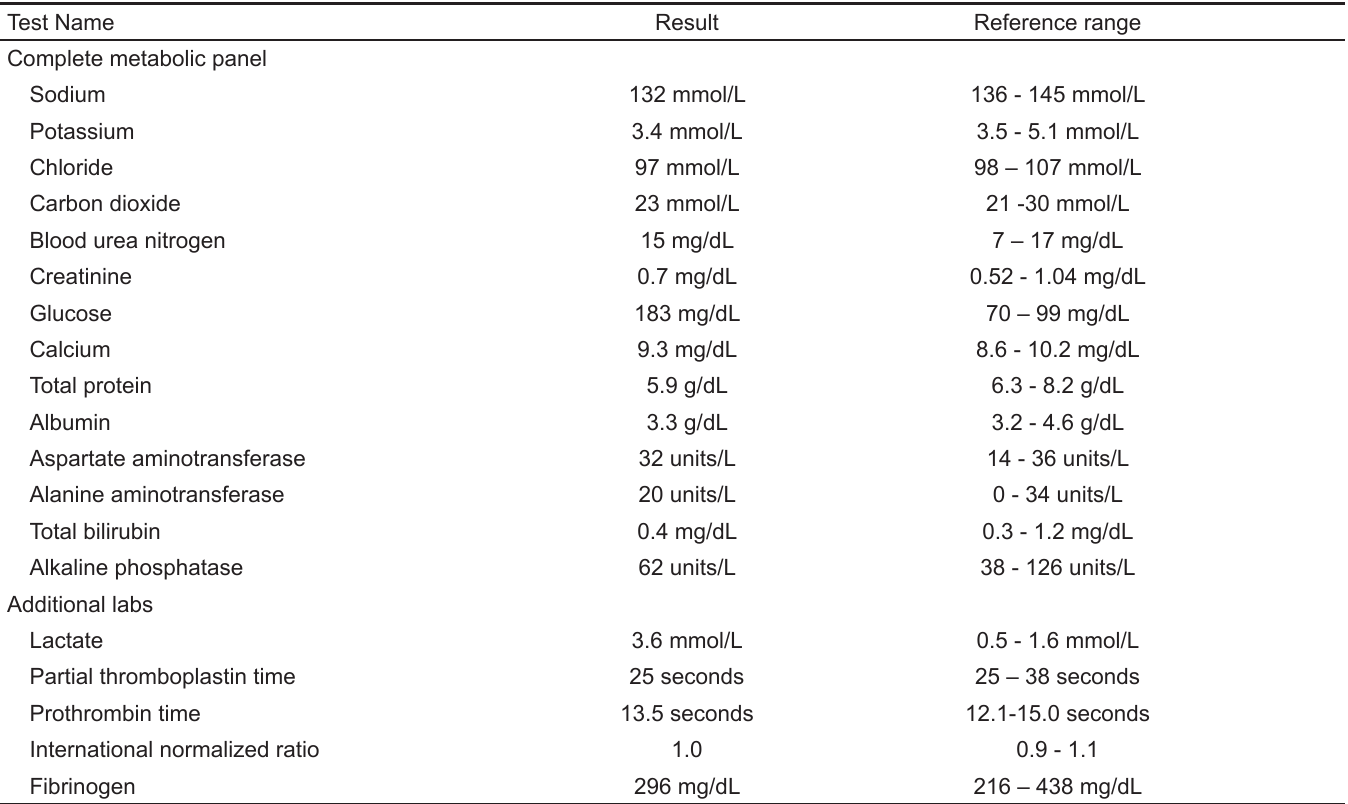
Table 2. Repeat laboratory results taken two hours after arrival of a 73-year-old female with syncope and subsequent motor vehicle collision.